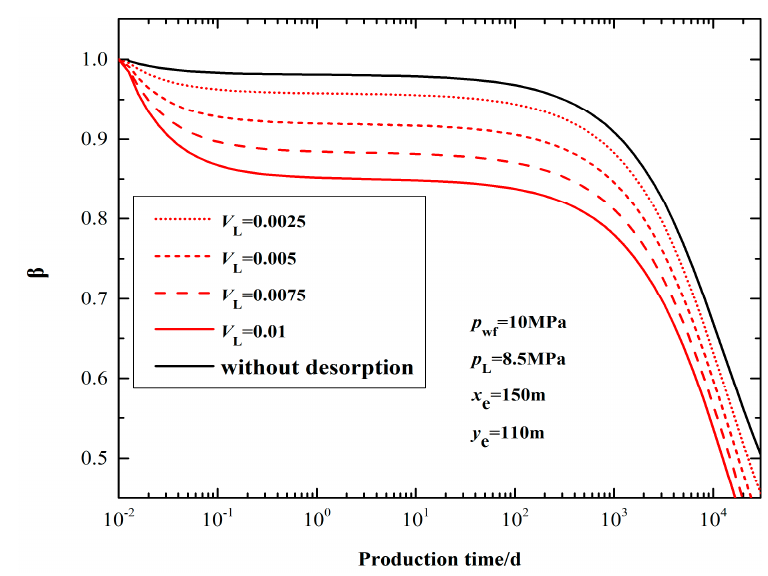
Figure 9. Effects of Langmuir volume on pseudo-time factor β ( t ). Energies 2017 , 10 , 1602